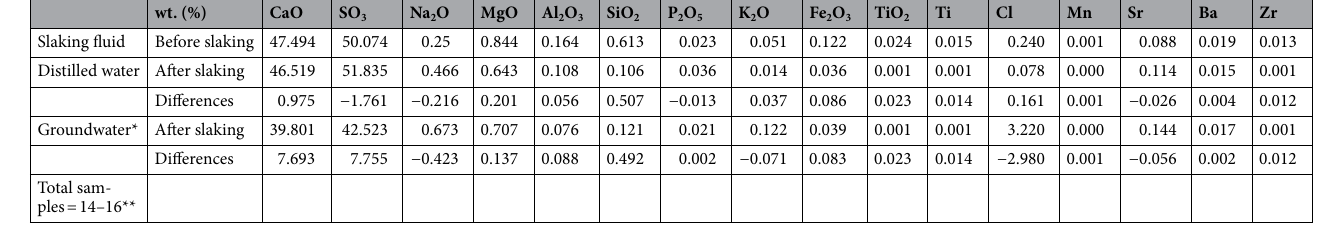
Table 2. Average chemical composition variation of evaporitic samples before and after slaking with distilled water and groundwater. *Groundwater specification: Groundwater level = 10–40 m, Temperature = 21.5–31.2 ◦ ( C), Salinity = 20,000–65,000 (ppm), pH = 7.14–9.45, TDS = 32,700–175,360 (ppm), EC = 28,100–274,000 (μ mhos/cm). **Chemical composition of two samples were missing in case of groundwater as a slaking fluid.